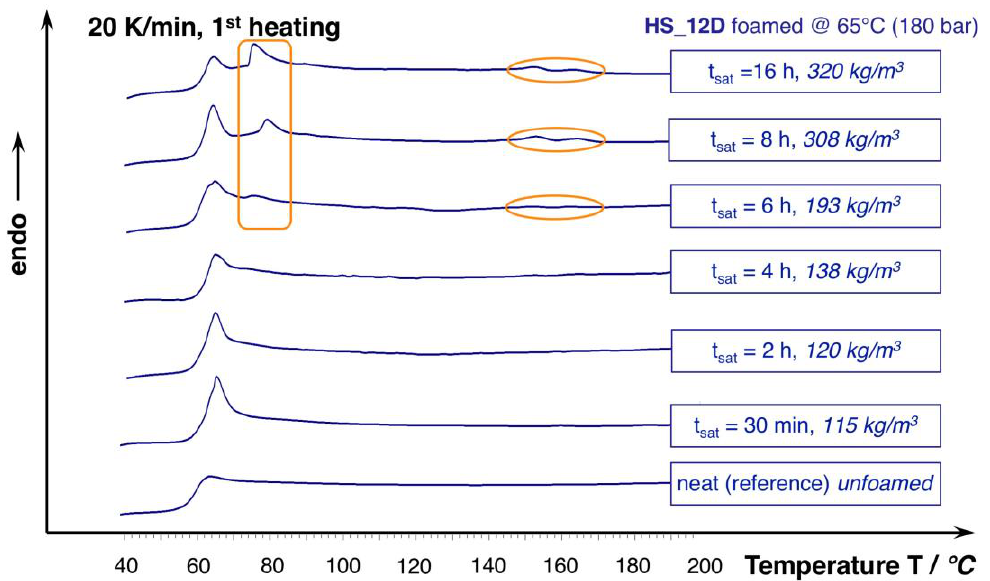
Figure 10. DSC curves of HS_12D foams and unfoamed reference (1 st heating, 20 K / min.).